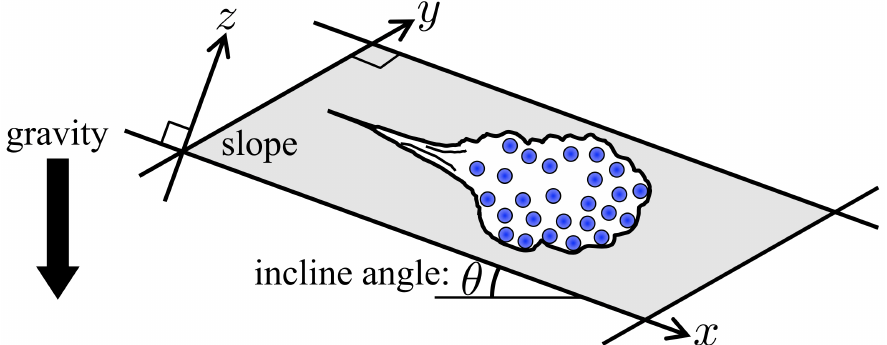
Figure 1. Schematic of a simple particle model. The x – y plane is parallel to the slope with the incline angle of θ ( x : inclination direction; y : lateral direction). The z -axis is perpendicular to the